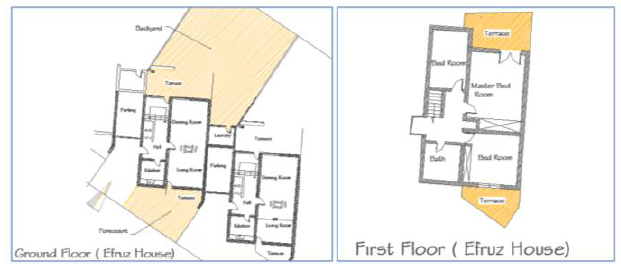
Figure 17. Exposed stone facades in Efrus